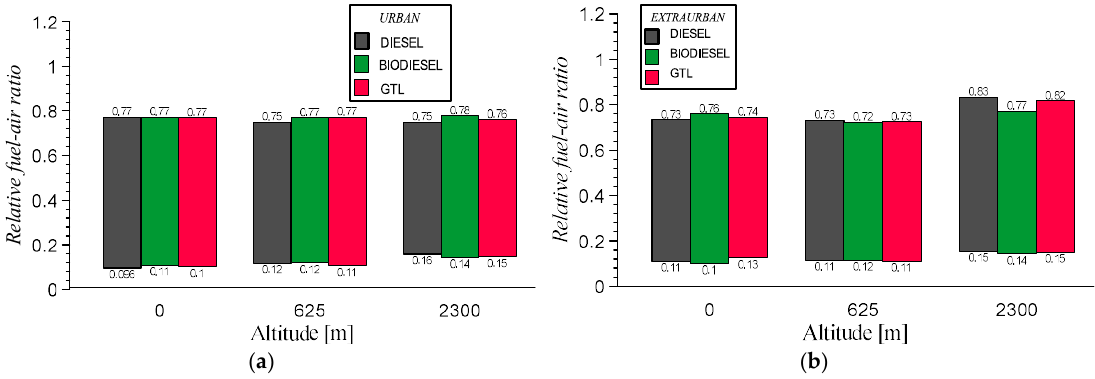
Figure 5. Operating range of the engine relative fuel-air ratio: ( a ) Urban driving conditions, ( b ) Extra-urban driving conditions .